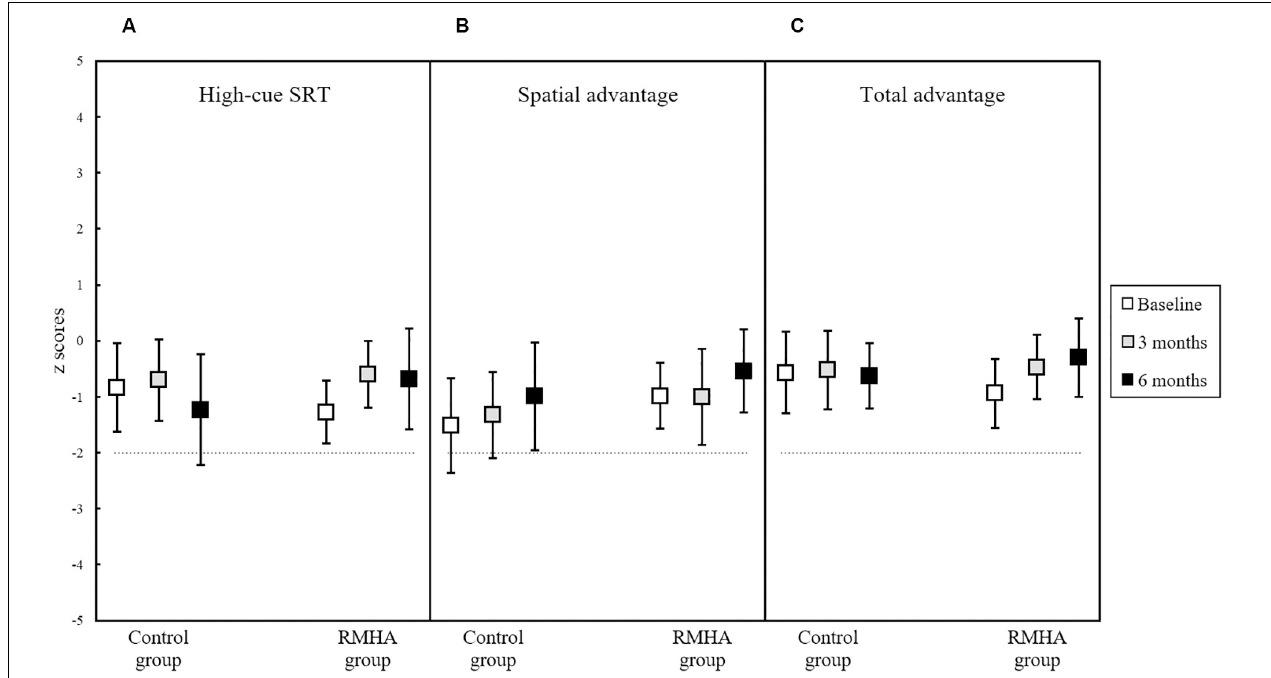
FIGURE 4 | Plots of mean z scores in (A) the High-cue SRT score, (B) the Spatial Advantage score, and (C) the Total Advantage score, for 13 controls and 12 RMHA children (and 13 controls and 13 RMHA children in the Spatial Advantage score only), at baseline, 3 months and at 6 months. Error bars represent a 95% CI of the mean. The horizontal dotted line indicates the cut-off for what is considered abnormal performance (i.e., − 2 z scores and below). One participant had two outlying cases in post-intervention testing at 6 months in the High-cue SRT and Total Advantage scores. Outliers were removed, as the participant had decreased focus and interest and had difficulty remaining seated during the fourth and final test condition. This condition is used to calculate both the High-cue SRT and Total Advantage scores, and because it is the last condition it can indicate auditory fatigue or declining attention in the subject (National Acoustic Laboratories, 2010). Removal of this case resulted in a comparison of 13 controls against 12 RMHA children in the analyses of these two conditions. CI, Confidence Interval; LiSN-S, Listening in Spatialised Noise – Sentences; RMHA, Remote Microphone Hearing Aid; SRT, Speech Reception Threshold.